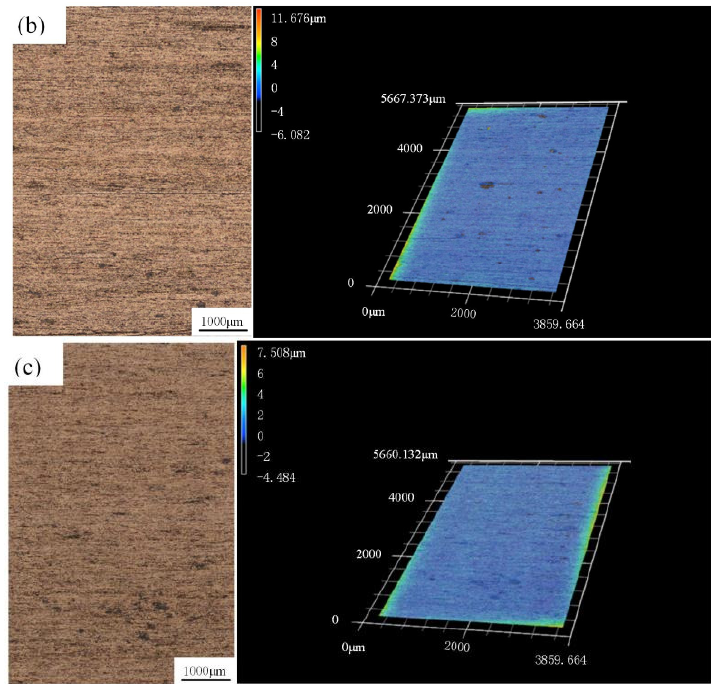
Figure 8. 3D surface topographies of rolled copper foils with different reductions: ( a ) 10%, ( b ) 30%, and ( c ) 50%.